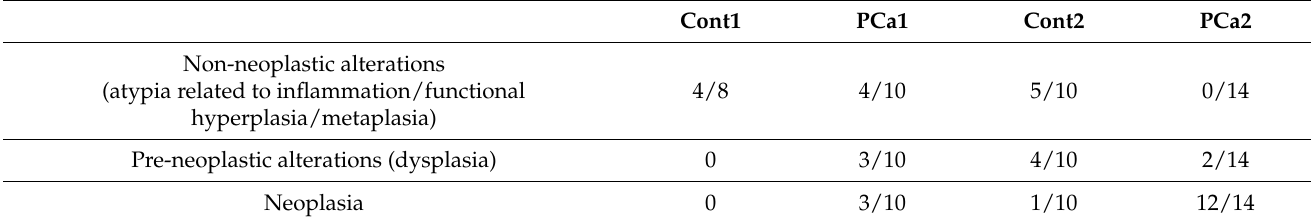
Table 2. Incidence of histopathological lesions of the prostate (in number of animals for each type of lesion per total number in the group; the coexistence of multiple lesions was observed in some animals). Cont1 PCa1 Cont2